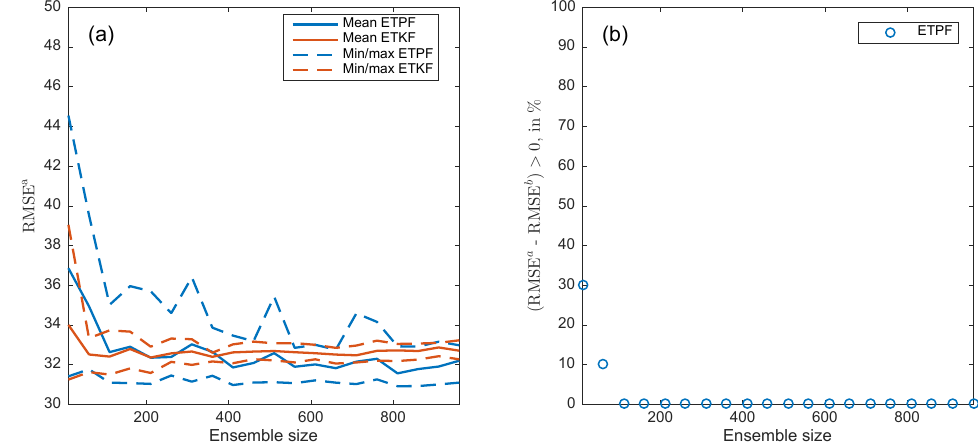
Figure 12. Using only three leading modes in the KL expansion. (a) RMSE after data assimilation w.r.t. ensemble size with mean, minimum and maximum over 10 simulations for ETPF shown in blue and ETKF in red. (b) % of simulations that result in ( RMSE a − RMSE b ) > 0 for ETPF.